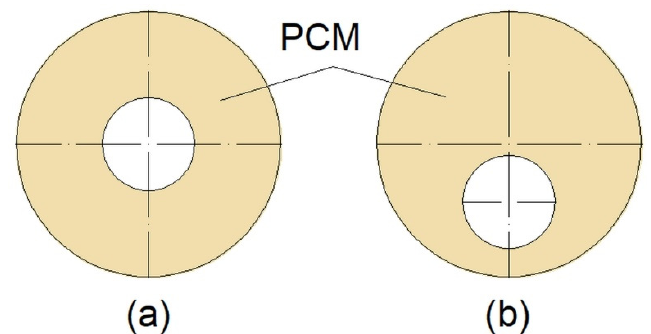
Figure 6. Cross-section of: ( a ) Concentric; ( b ) non-concentric Double-Tube Heat Exchanger (DTHX) [16].